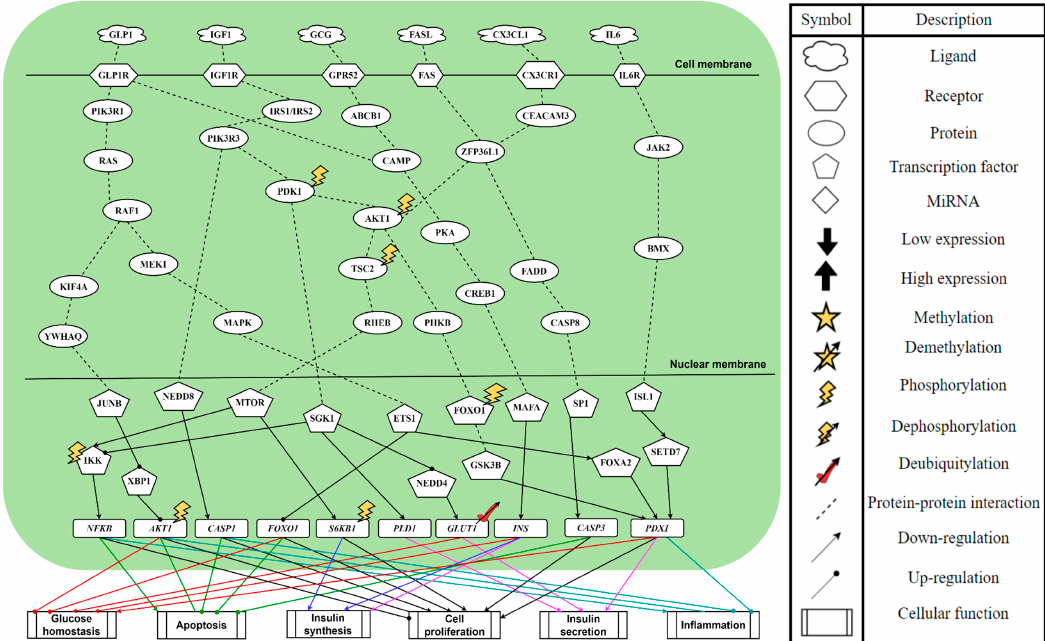
Figure A3. The core signaling pathways of non-T2D based on our result for investigating the non-T2D genetic and epigenetic molecular mechanism. The genes and proteins in the core signaling pathways were chosen from the non-T2D core GWGENs. The gene regulations and protein interactions were constructed on the basis of the edges in non-T2D core GWGENs. The cellular functions caused by target genes are clustered with solid lines in different colors.